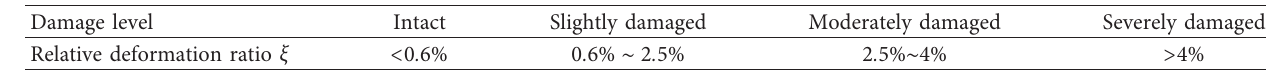
Table 6: Seismic failure grades of tunnel structure based on relative deformation